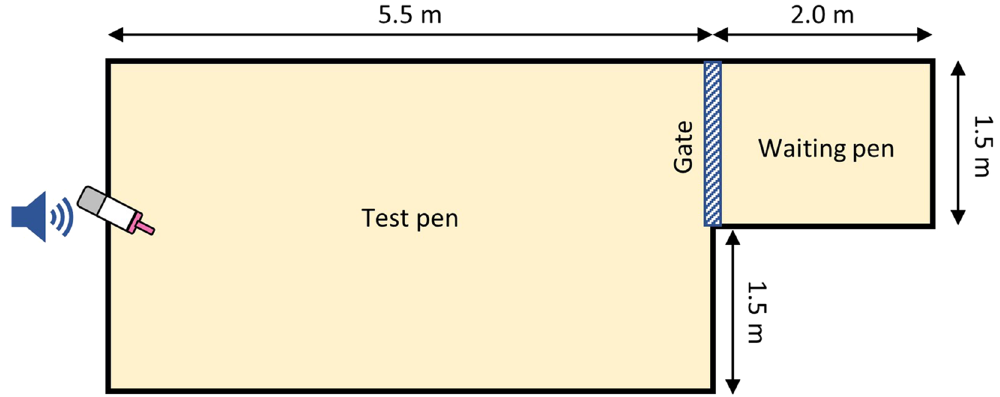
Figure 1. Aerial view of the arena used for startle tests, including the position of the milk bottle and speaker used to broadcast the startle noise. Figure is drawn to scale.